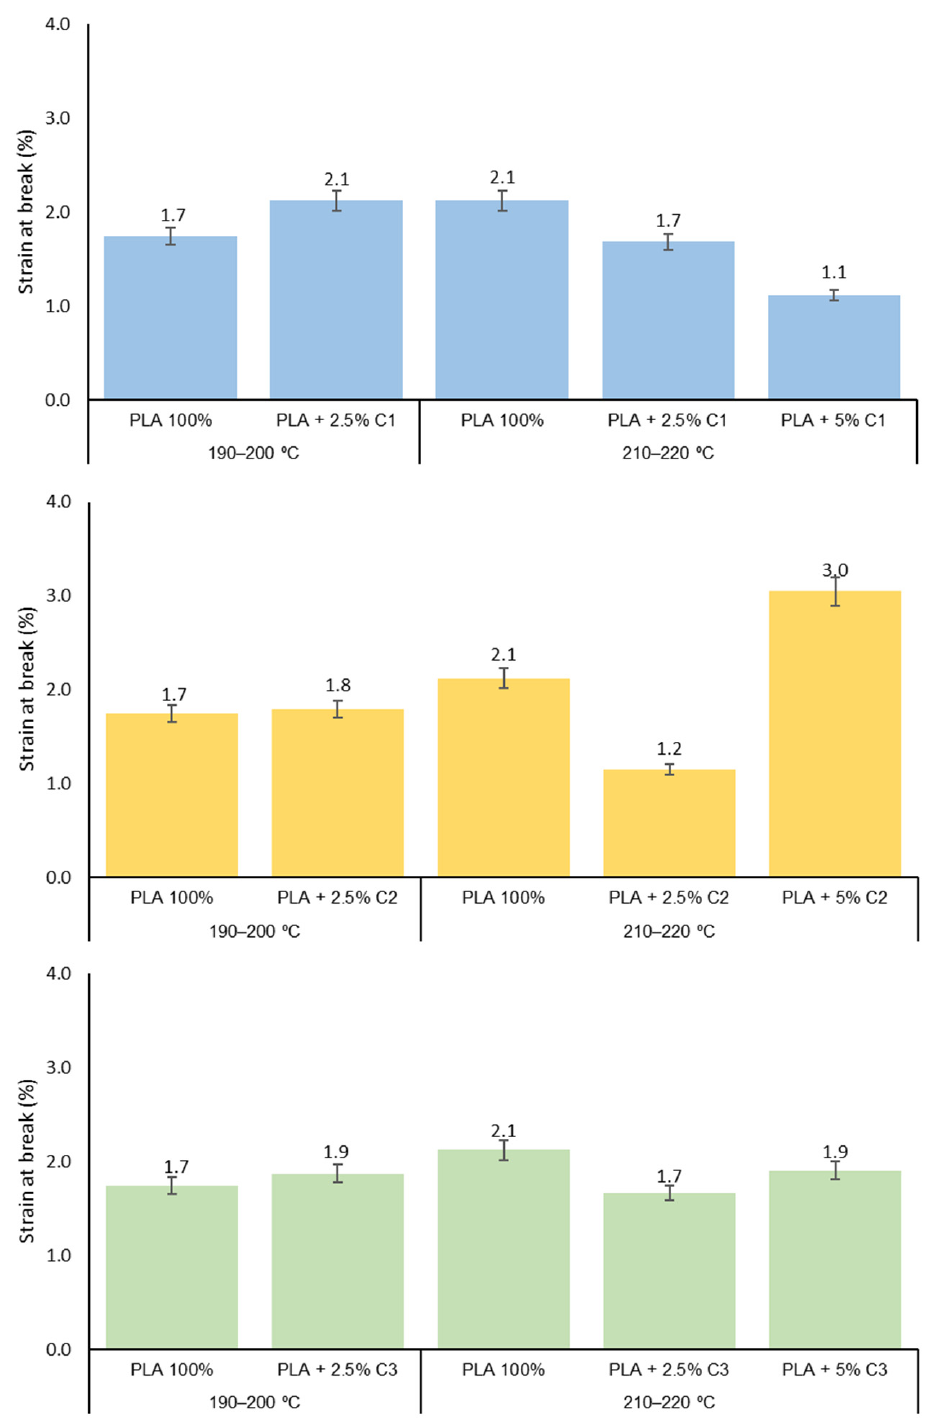
Figure 6. Strain at break of PLA 100%, PLA + 2.5% and PLA + 5% concentrations of compatibilizer samples extruded at 190–200 ° C and 210–220 ° C.